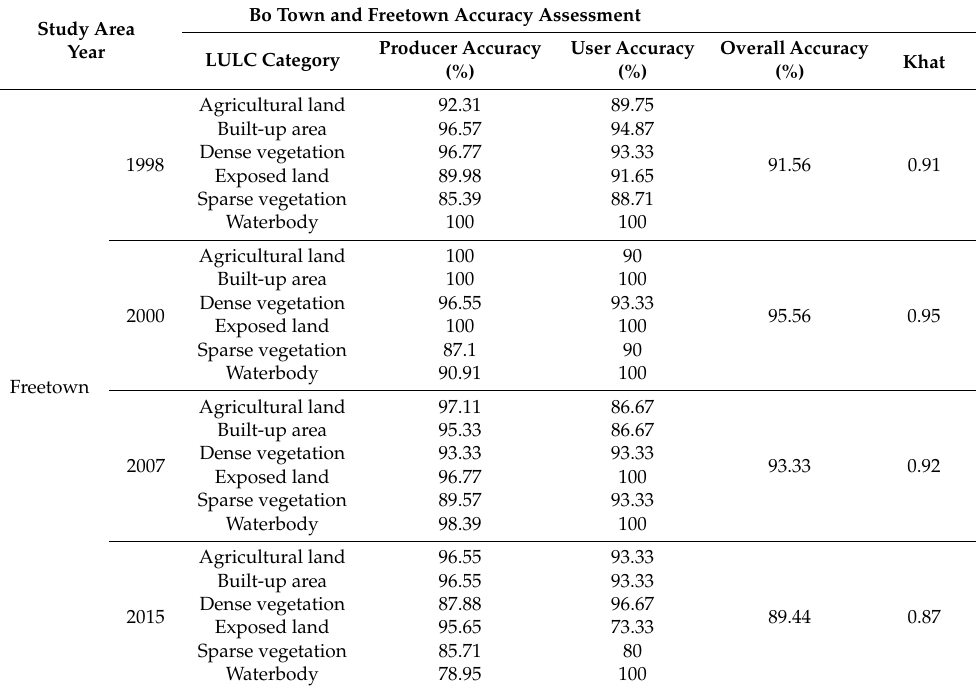
Table A1. Accuracy statistic for multi-temporal LULC